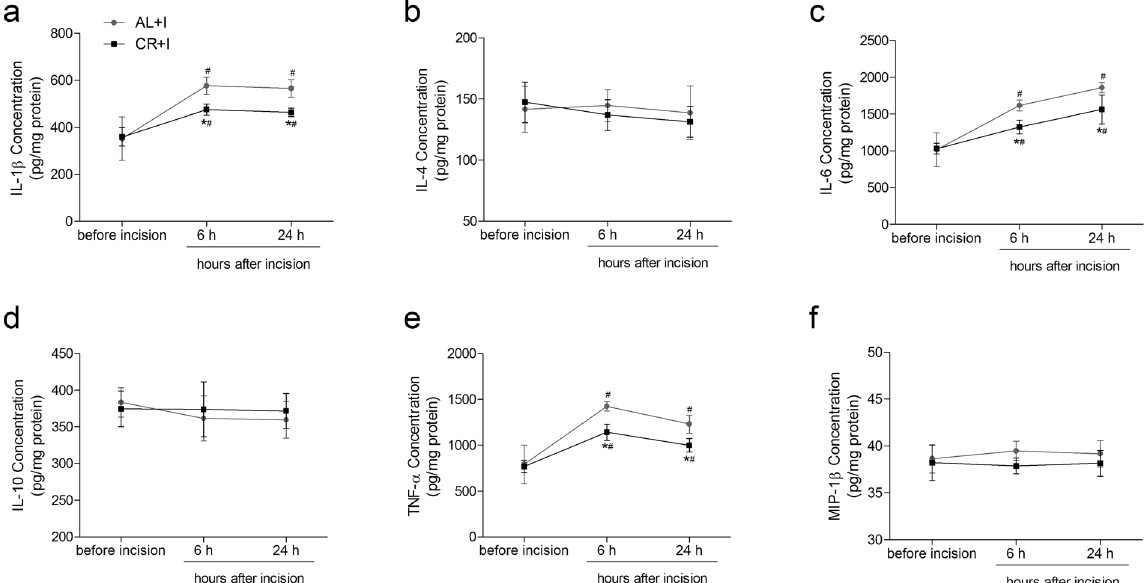
Figure 6. Effects of caloric restriction on pro-inflammatory and anti-inflammatory cytokines in ipsilateral spinal cord dorsal horn after incision. Levels of IL-1 β ( a ), IL-4 ( b ), IL-6 ( c ), IL-10 ( d ), TNF- α ( e ) and MIP-1 β ( f ) in ipsilateral spinal cord dorsal horn (pg/mg protein) measured before, 6 h, and 24 h after incisional surgery (n = 5). Values expressed as mean ± SD. The treatment style was same as described in Fig. 1. Significant difference was revealed after two-way ANOVA ( * P < 0.05 in comparison of group CR + I with group AL + I, # P < 0.05 compared with baseline, Bonferroni post hoc